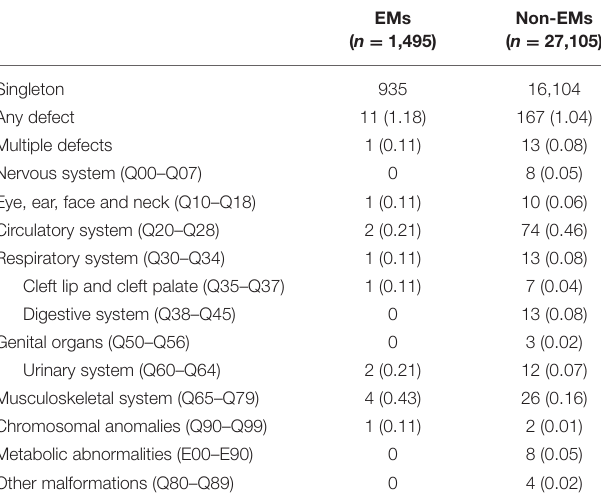
TABLE 3 | Proportion for birth defects of singleton